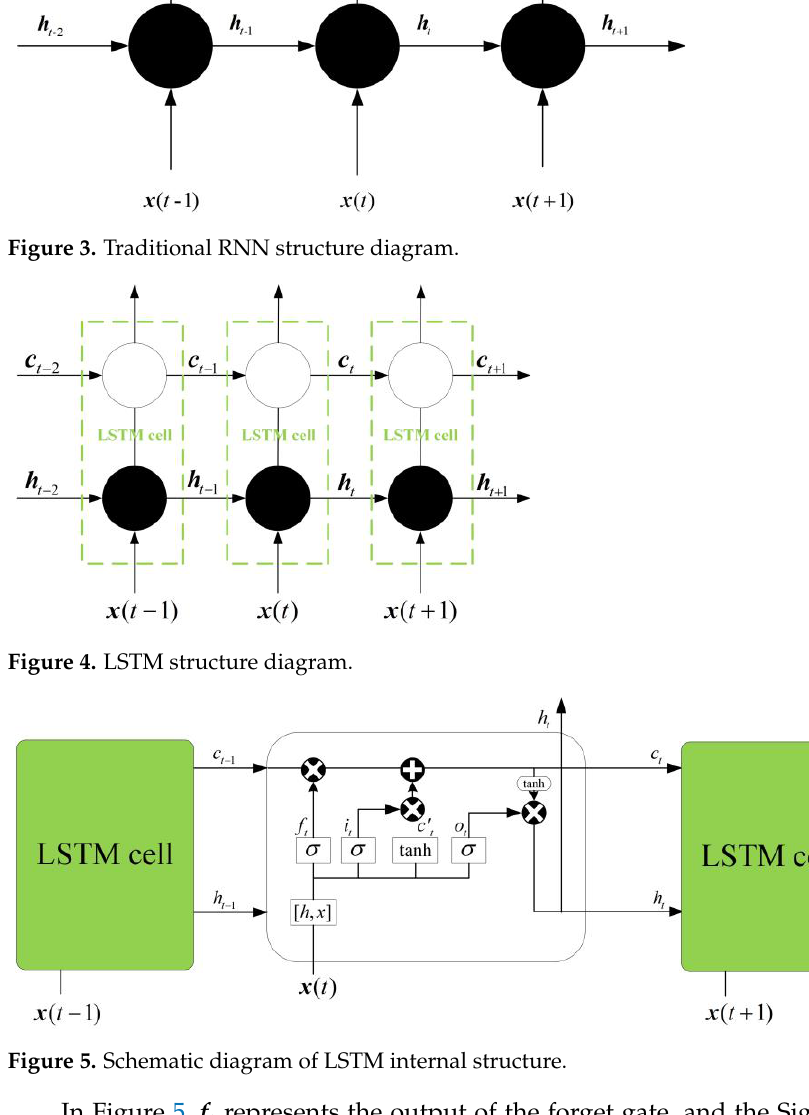
Figure 5. Schematic diagram of LSTM internal structure.